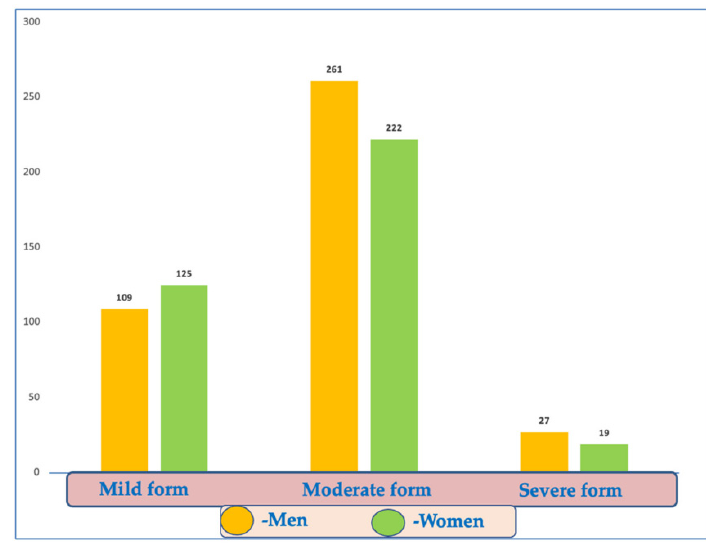
Figure 2. Required hospitalization days according to gender.